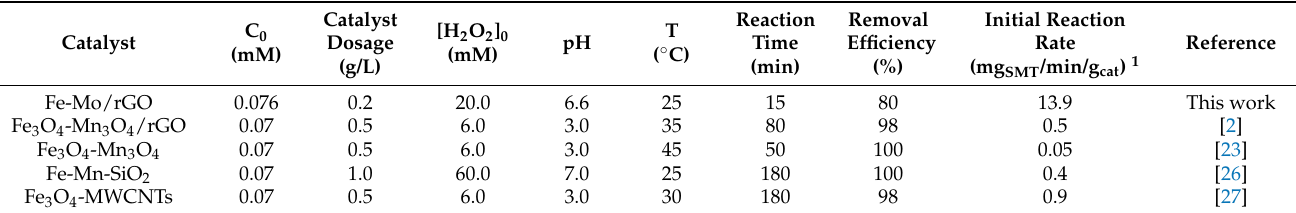
Table 1. The SMT degradation over different iron-based catalysts in Fenton-like